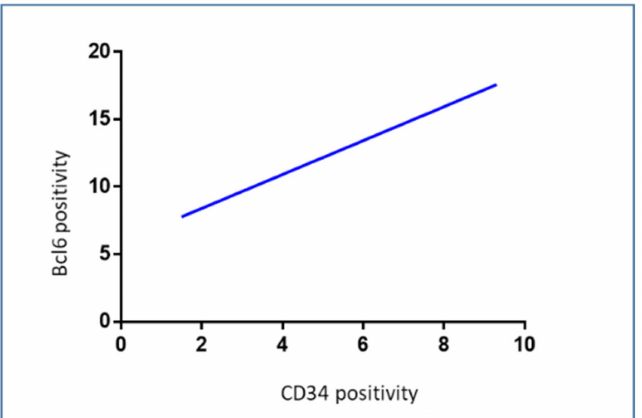
Figure 7. Regression analysis graph indicating the correlation between Bcl6 and CD34 in GBM samples (rho = 0.58, p =